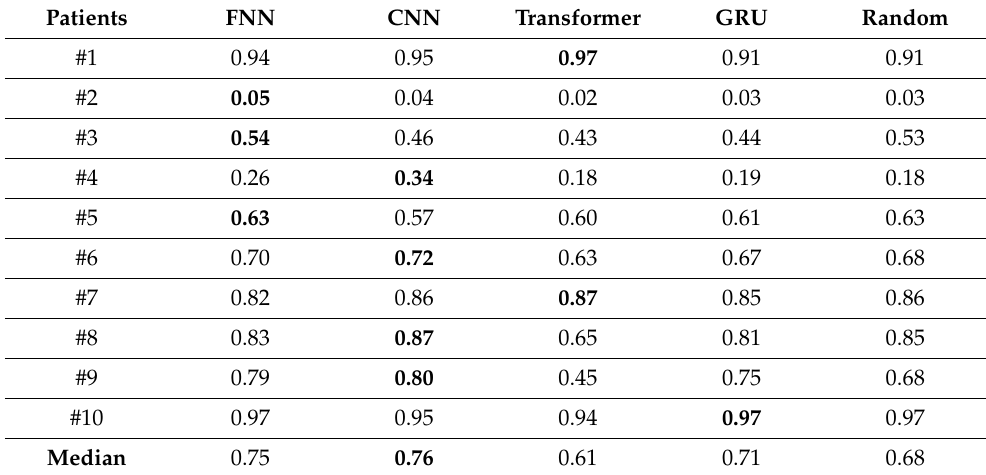
Table 6. Results for PR-AUC (personalized scheme). 1